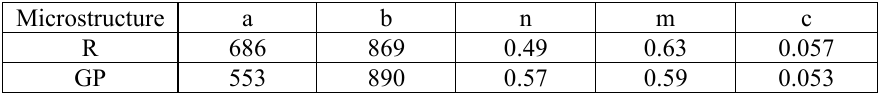
Table 1: Computed JCM parameters for the R and GP configurations